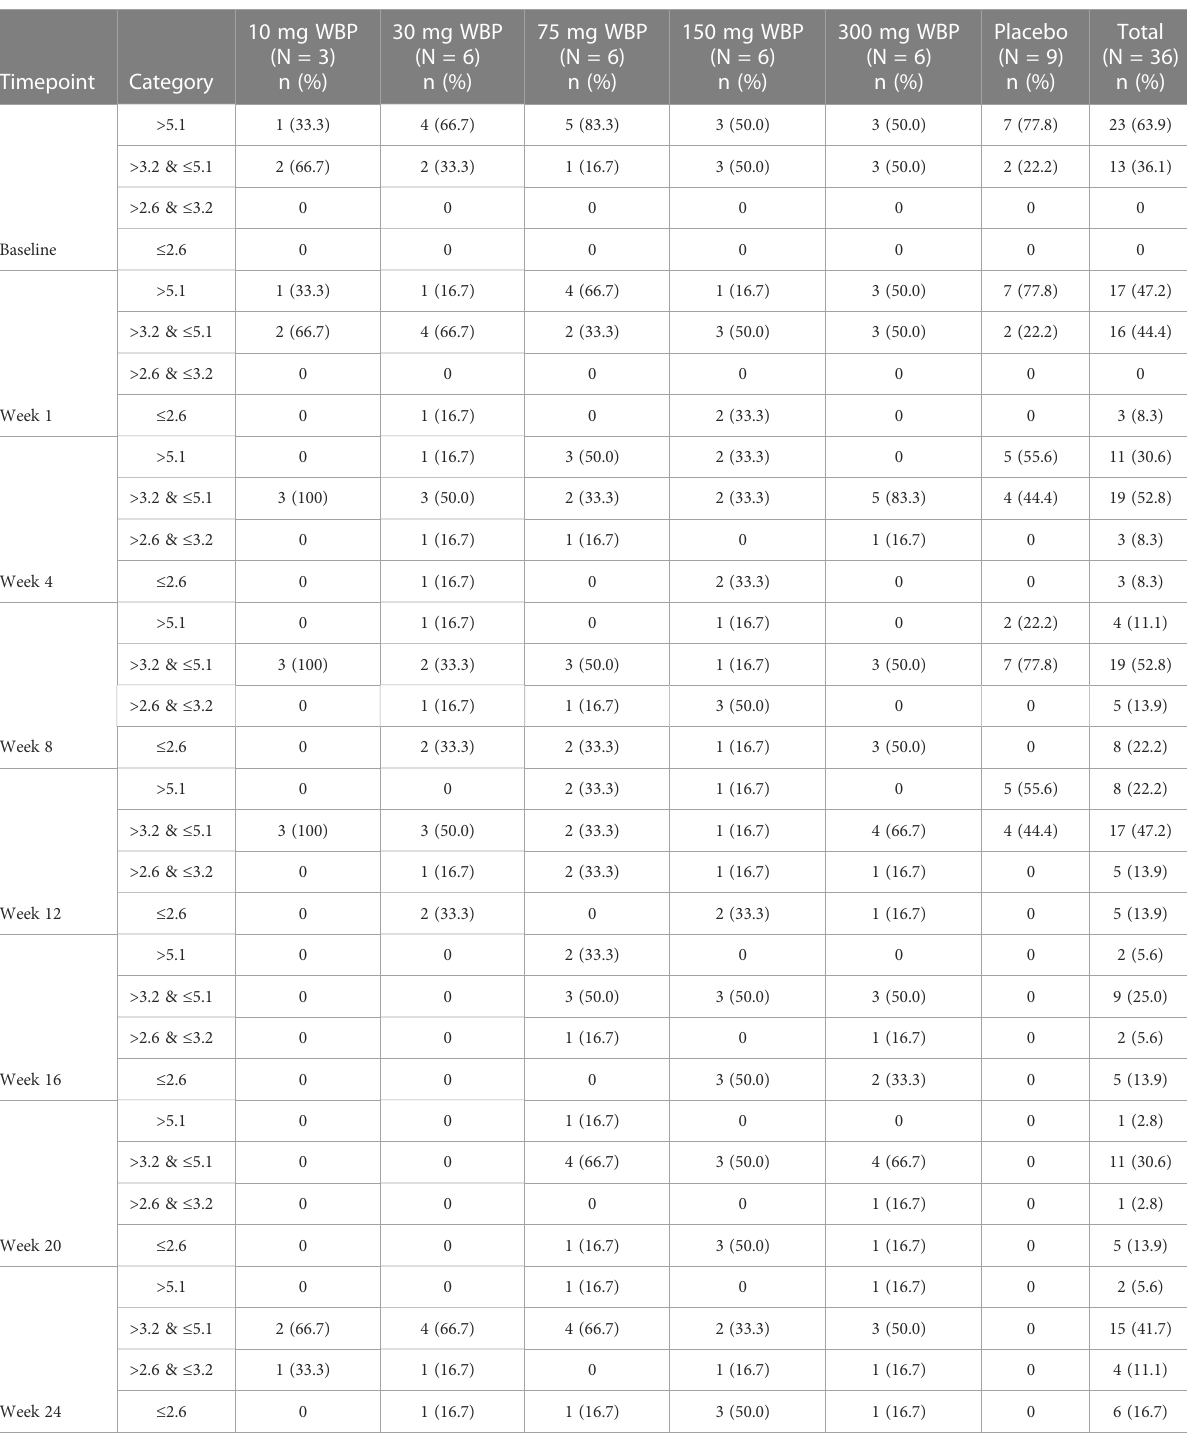
TABLE 4 Summary of DAS28 disease activity: Ef fi cacy analysis